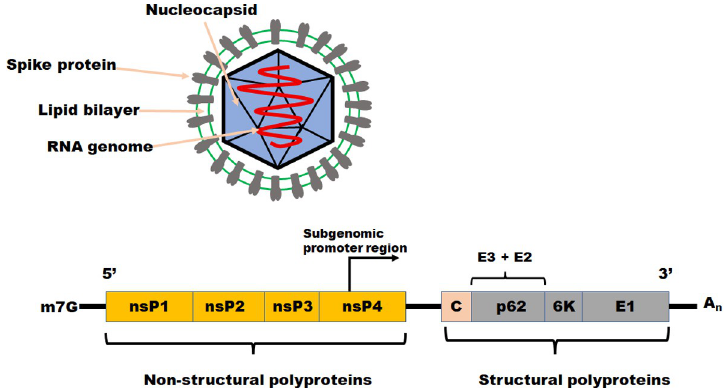
Fig 1. The vision of an alphavirus and the arrangement of its genome this image shows the nucleocapsid of an alphavirus virion, composed of a 42S RNA genome (red) in plus-sense orientation and capsid proteins (sky blue). Virus glycoproteins E1 and E2 heterodimers (grey) are embedded in a lipid bilayer (green) surrounding the nucleocapsid, enclosed by a lipid bilayer.